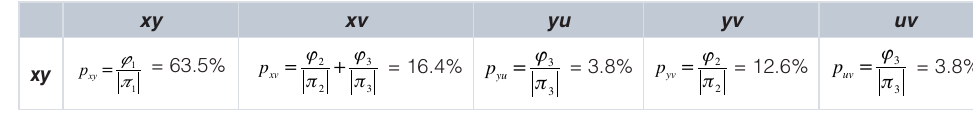
Table 2. Proportion contributions of direct comparisons to the ‘ x versus y ’ network meta-analysis treatment effect in the network of topical antibiotics without steroids for chronically discharging ears.